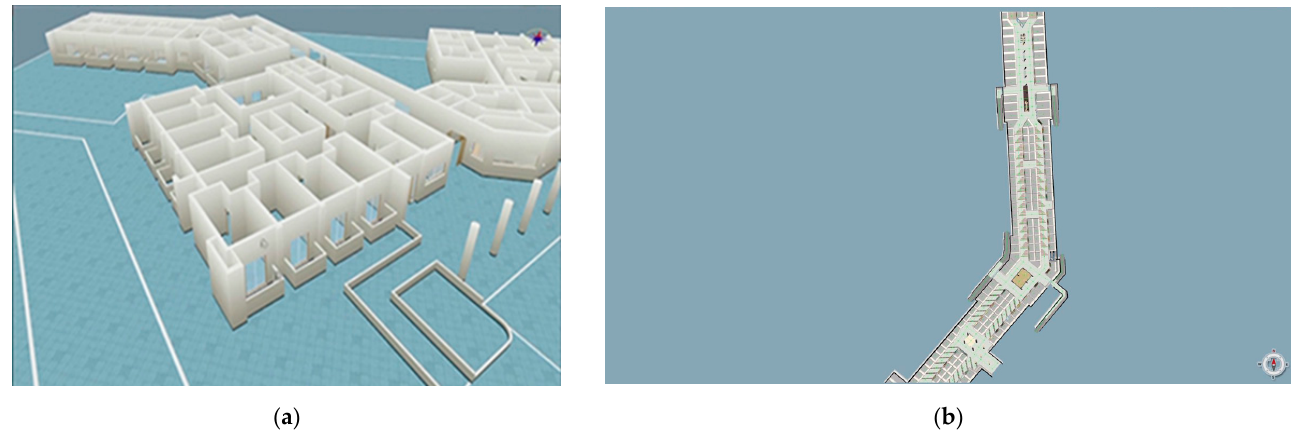
Figure 5. Store-level 3D spatial data generation through 3D modeling and attribute information input. ( a ) 3D modeling. ( b ) Final result. The file format is 3DS.